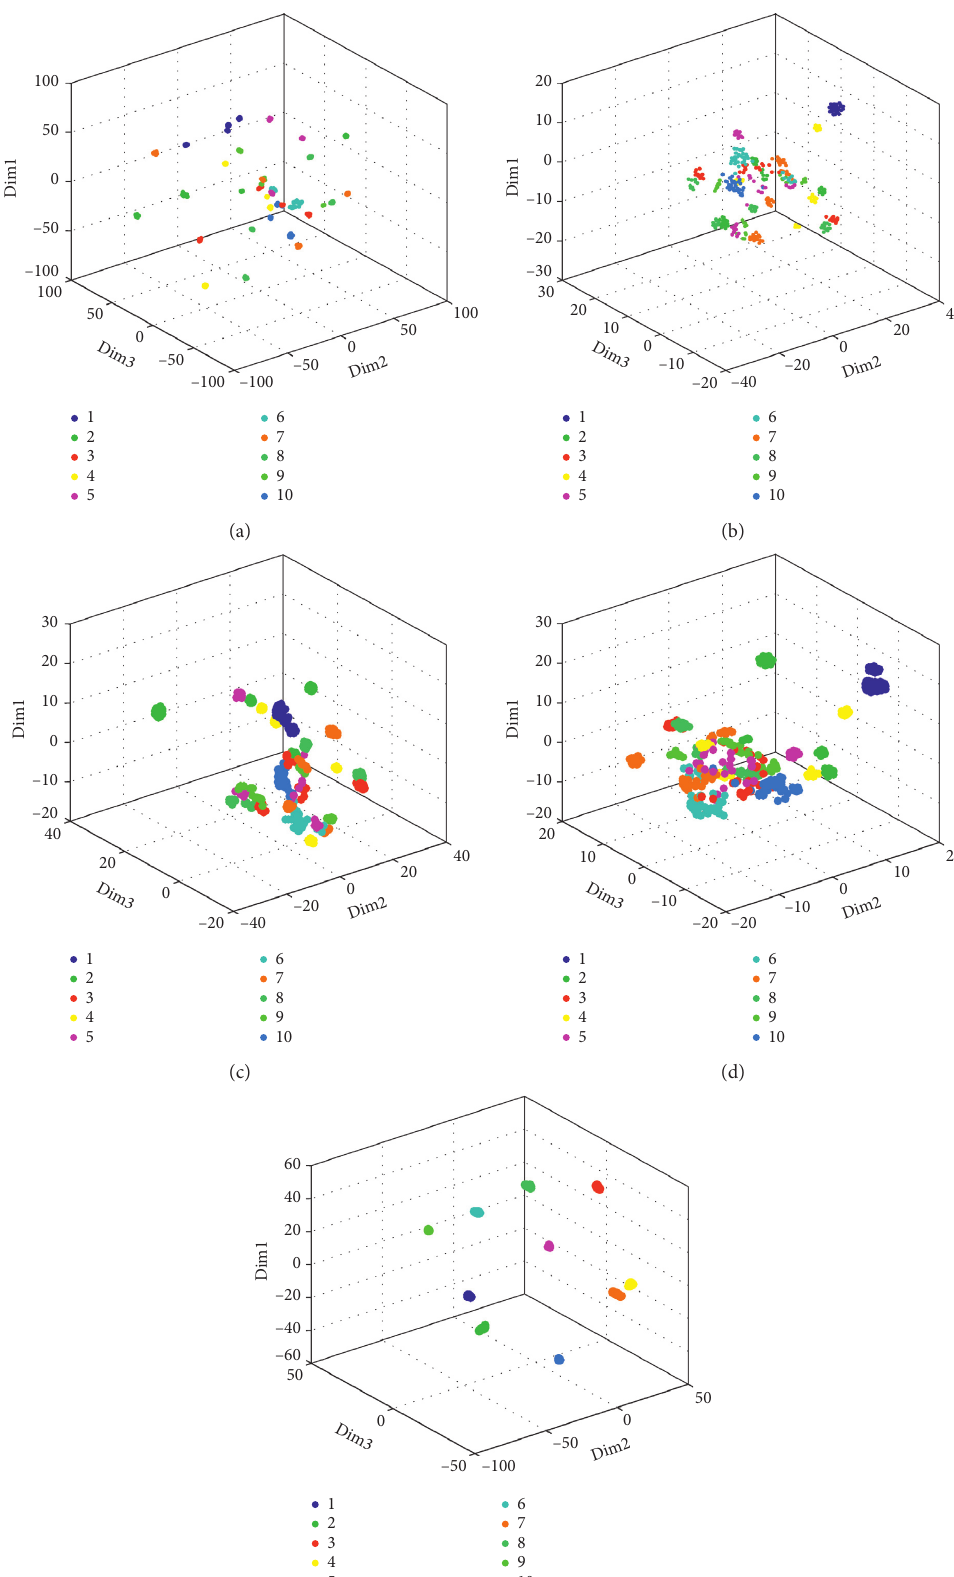
Figure 3: t-SNE results of output in different levels for bearing training samples: (a) input level; (b) first hidden level; (c) second hidden level; (d) third hidden level; (e) output